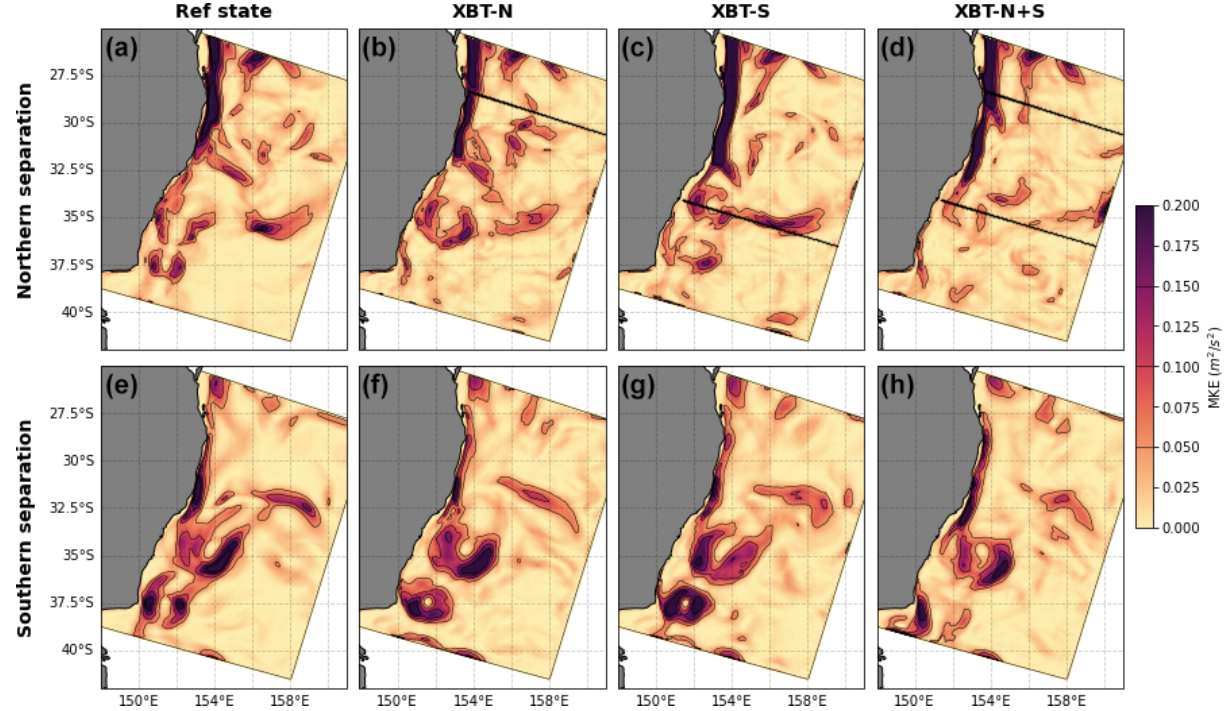
Figure 9. The surface MKE is compared between the (a) reference state, (b) XBT-N, (c) XBT-S, and (d) XBT-N+S for the case when the EAC is in a northern separation phase. For the southern separating EAC phase, the surface MKE is compared between the (e) reference state and the (f) XBT-N, (g) XBT-S, and (h) XBT-N+S. Black lines in panels (b–d) indicate location of the XBT